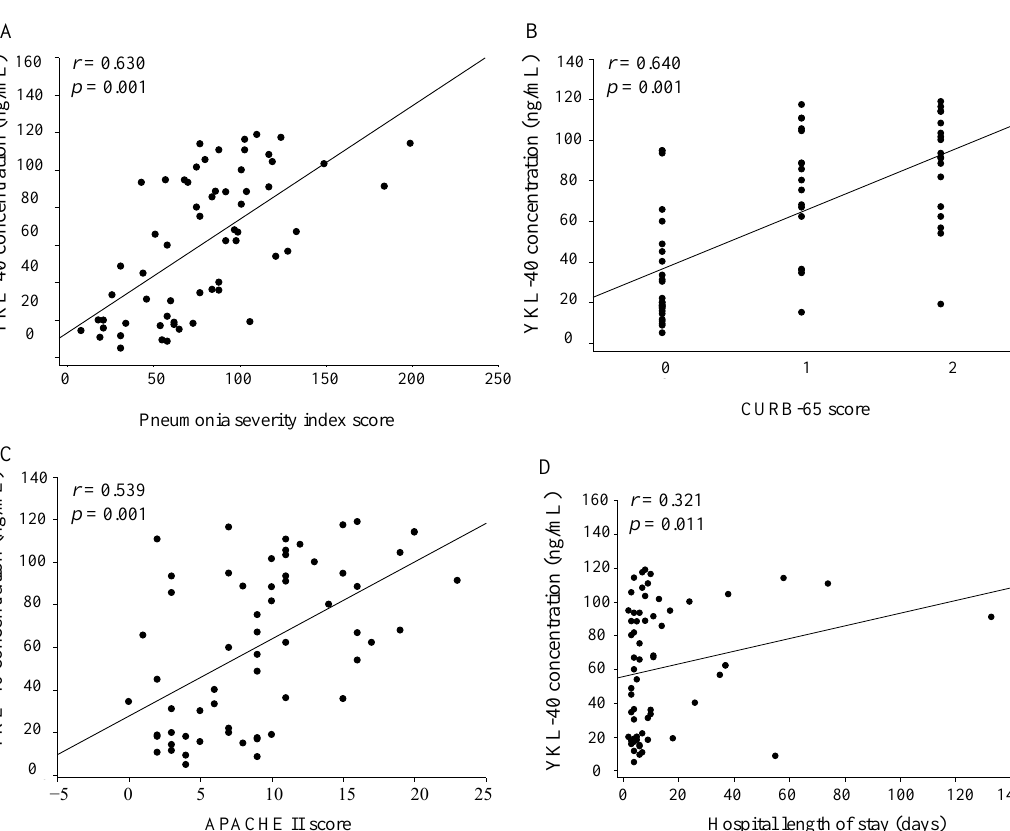
Figure 2. Analysis of the correlation between YKL-40 expression with PSI, CURB-65, APACHE II scores and hospital length of stay. Before treatment, CAP patients exhibited correlations among PSI, CURB-65, APACHE II scores, hospital length of stay and YKL-40 expression. There were significant correlations between YKL-40 and PSI (Spearman correlation coefficients r = 0.630, p < 0.001, n = 61; ( A ) CURB-65 (Spearman correlation coefficients r = 0.640, p < 0.001, n = 61; ( B ) APACHE II (Spearman correlation coefficients r = 0.539, p < 0.001, n = 61; ( C ) and hospital length of stay (Spearman correlation coefficient r = 0.321, p =0.011, n = 61; ( D ) in CAP patients before they received treatment.